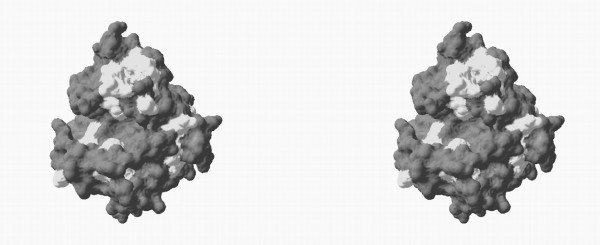
3D mapping of the amino acids onto the 3D structure of BglII. Mutagenically interesting positions (light grey) are mapped over the molecular structure of the catalytic domain of BglII, selected as a representative structure of family 16 glycosyl hydrolases (order number 1 in Table 2). This figure is a cross-eyed stereogram.